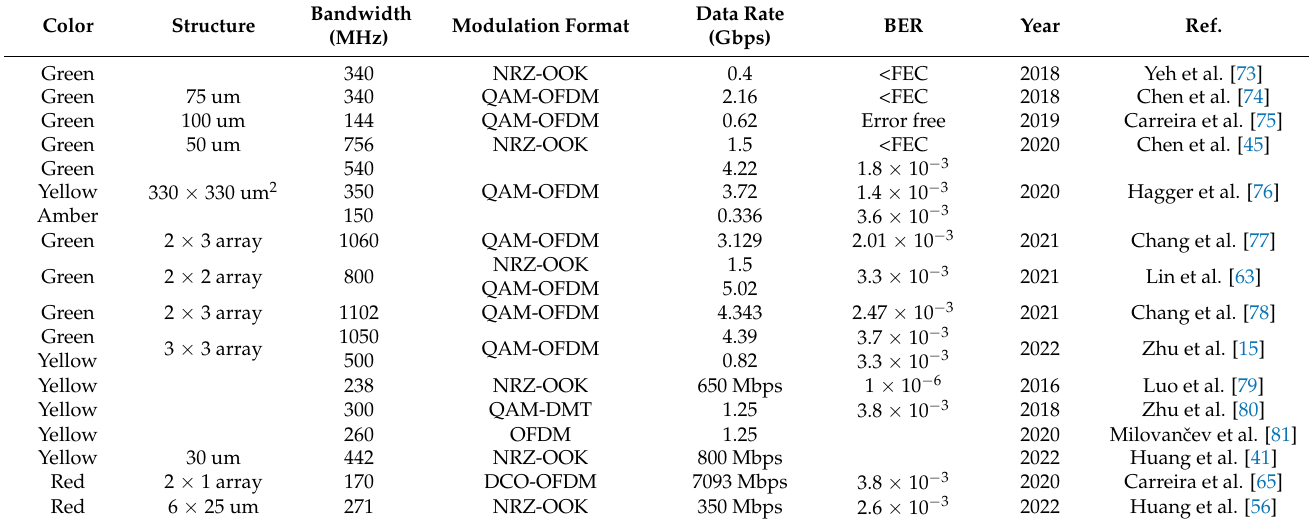
Table 1. Modulation characteristics comparison between Micro-LEDs and mini-LEDs emitting yellow–green to red